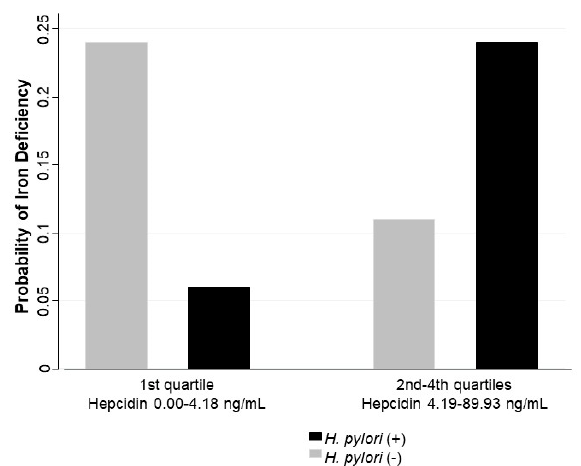
Figure 1. Predicted probabilities to iron deficiency by H. pylori infection and hepcidin categories, multivariate model Table 4.